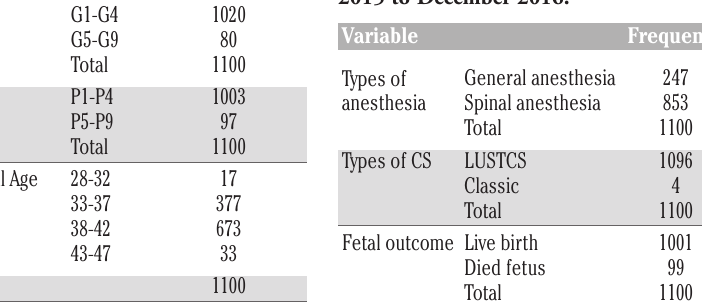
Table 6. Types of anesthesia used during cesarean section at DBRH from January 2015 to December